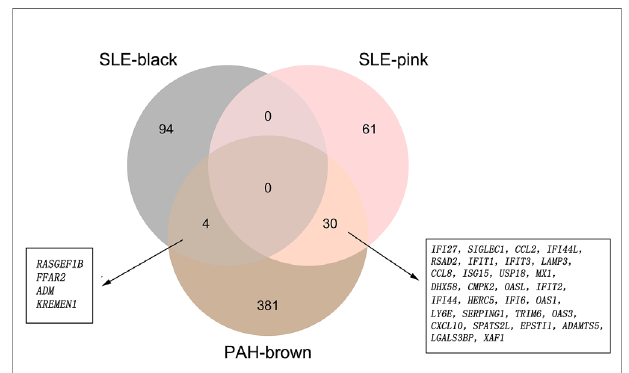
FIGURE 2 | The shared genes between the black and pink modules of SLE and brown module of PAH by overlapping them. SLE, systemic lupus erythematosus; PAH, pulmonary arterial hypertension.